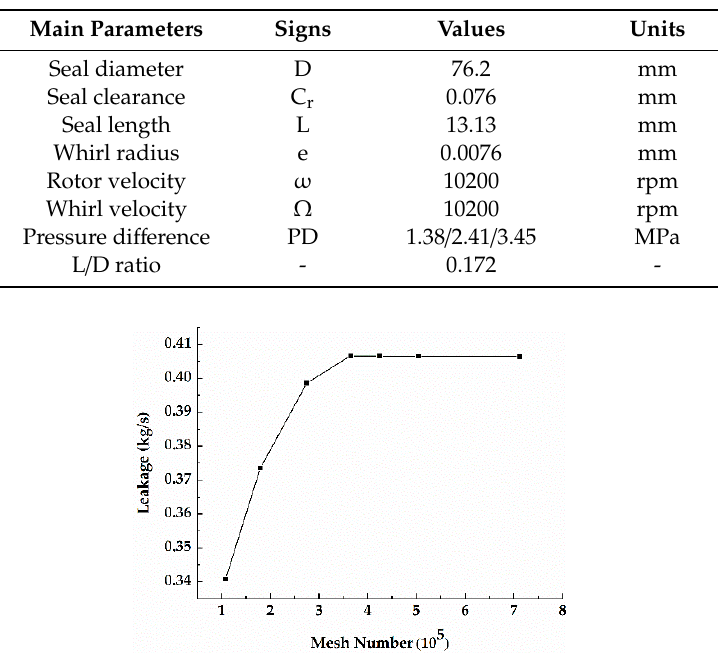
Figure 2. ( a ) Calculation domain and ( b ) grid. Table 1. Geometric parameters and operation conditions. Table 1. Geometric parameters and operation conditions.